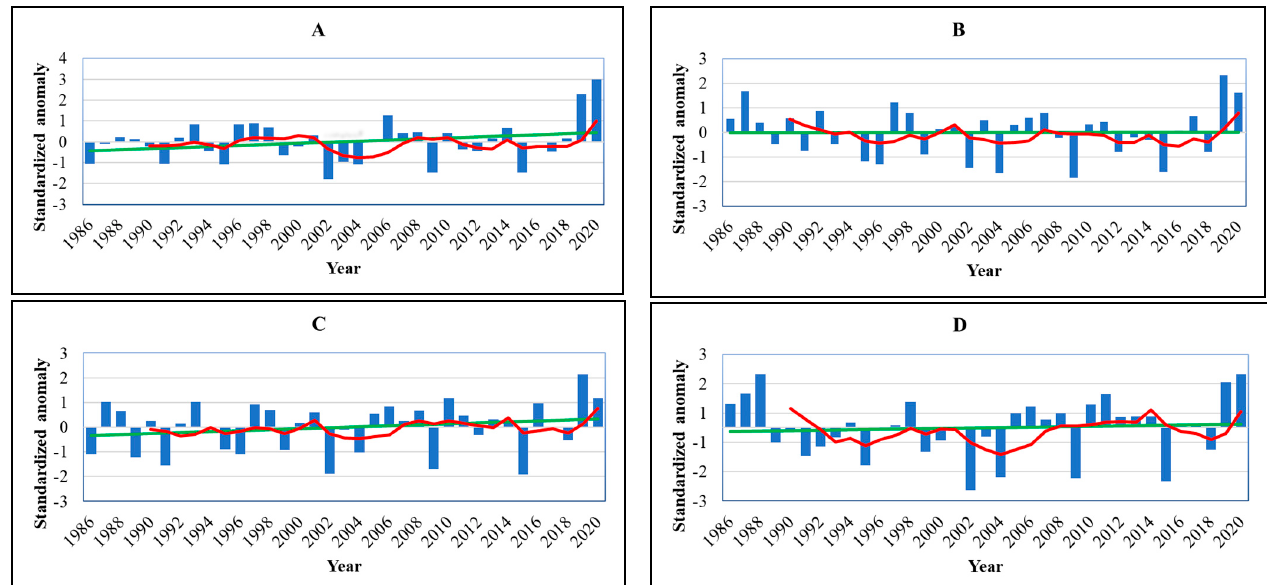
Figure 4. Mean country-wide extreme rainfall indices in the period between 1986 and 2020: ( A ) PRCPTOT, ( B ) Rx1day, ( C ) Rx5day, and ( D ) SDII. Note: The straight green line is the linear trend for the variables while the red curved line is the five-year moving average.